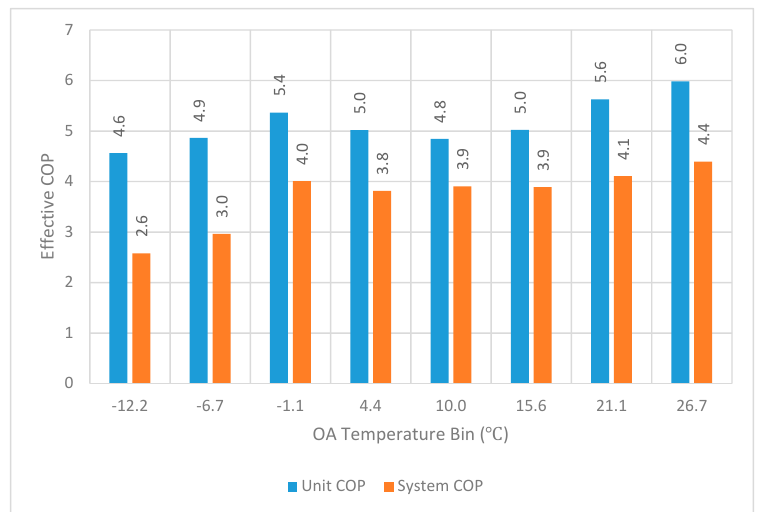
Figure 9. Effective coefficient of performances (COPs) of the water-to-water heat pumps (WWHPs) and the recycled water heat pump (RWHP) system versus outdoor air temperatures.